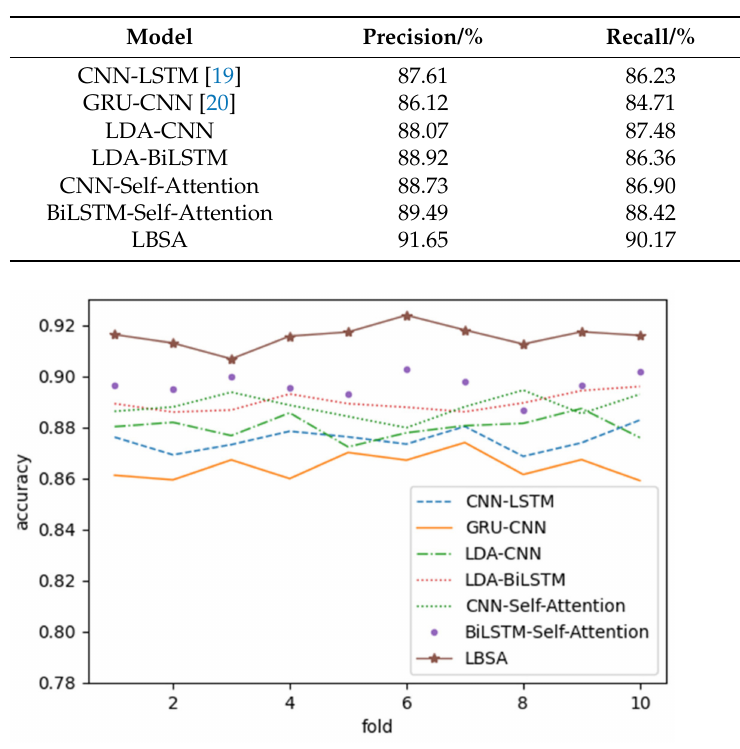
Figure 6. Comparison of Accuracy in 10-fold